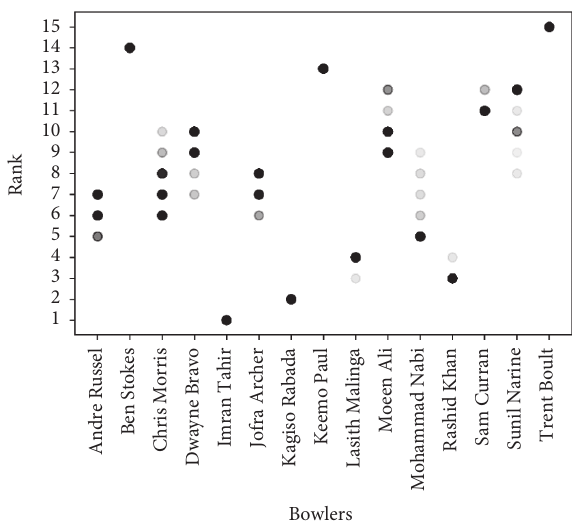
Figure 10: Heat map for bowlers ranks by TODIM through varying θ .